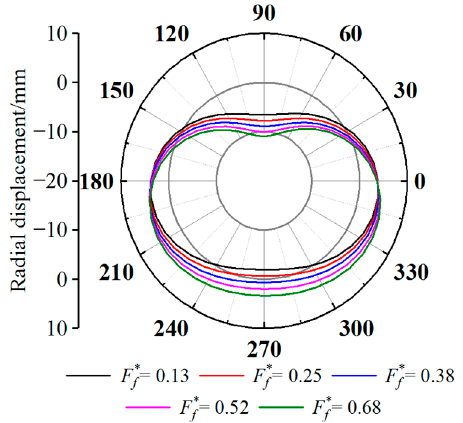
F ∗ . Figure 22. Lining ovality under different friction coefficients F ∗ f f